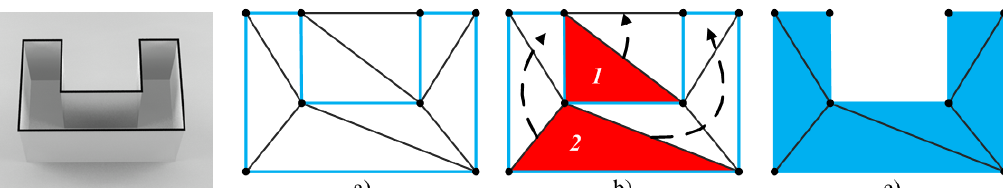
Figure 9. Illustration of Constraint IV (a) the 2D projection of the tetrahedralized result of the left case: a tessellated coplanar surface where boundary edges of fixed triangles are colored in blue; b) the connected neighbours of two candidate; c) carving result when applying the constraint